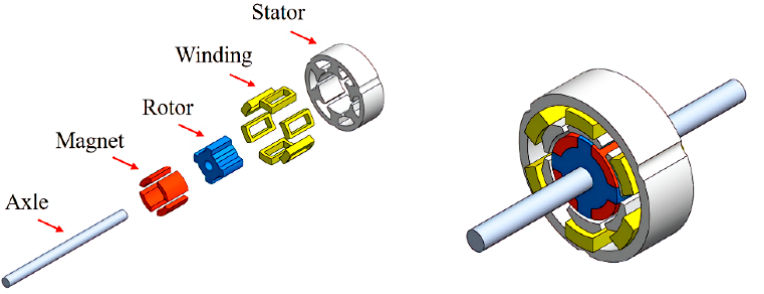
Figure 34. Futuristic permanent magnet synchronous motor with highly conductive composites [86].